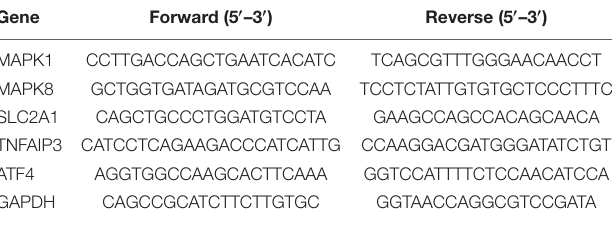
TABLE 1 | Specific primers used for quantitative real-time